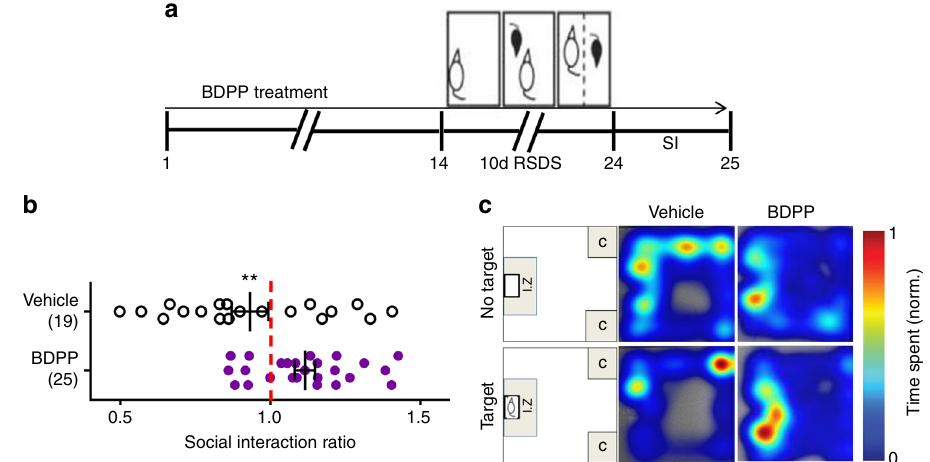
Fig. 1 Oral administration of BDPP promotes resilience to RSDS. a Schematic design of the experiment. b Treatment with BDPP increases the proportion of mice showing a resilient phenotype, as measured by social interaction ratio (two-tailed unpaired t -test, t 42 = 2.786, P = 0.008). c Representative heatmaps of social avoidance behavioral test. Graphs represents mean ± s.e.m., ** P <